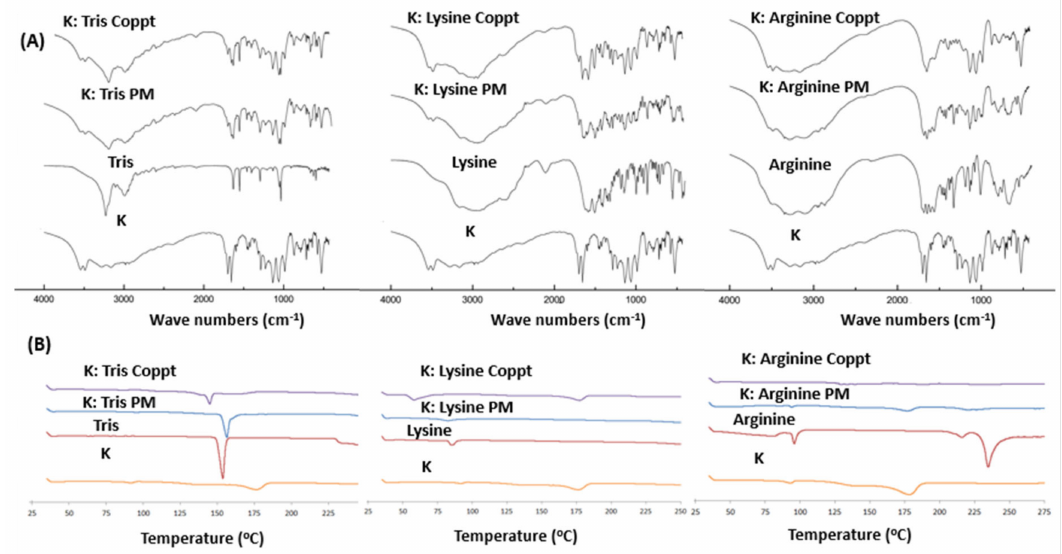
Figure 4. ( A ) FTIR spectra and ( B ) DSC thermograms of ketoprofen (K), basic excipients (tris, lysine, and arginine), physical mixtures (PM), and coprecipitated dispersed mixtures